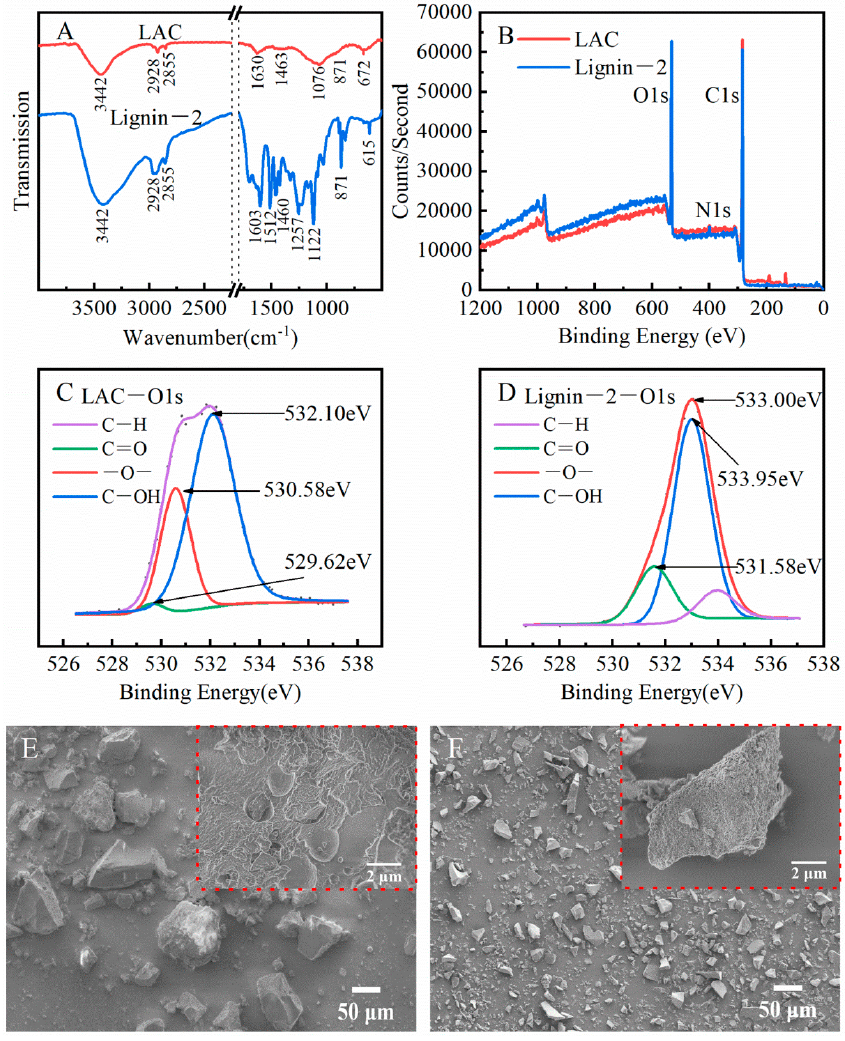
Figure 5. ( A ) FTIR spectra, ( B – D ) XPS spectra and ( E , F ) SEM of lignin-2 and LAC.